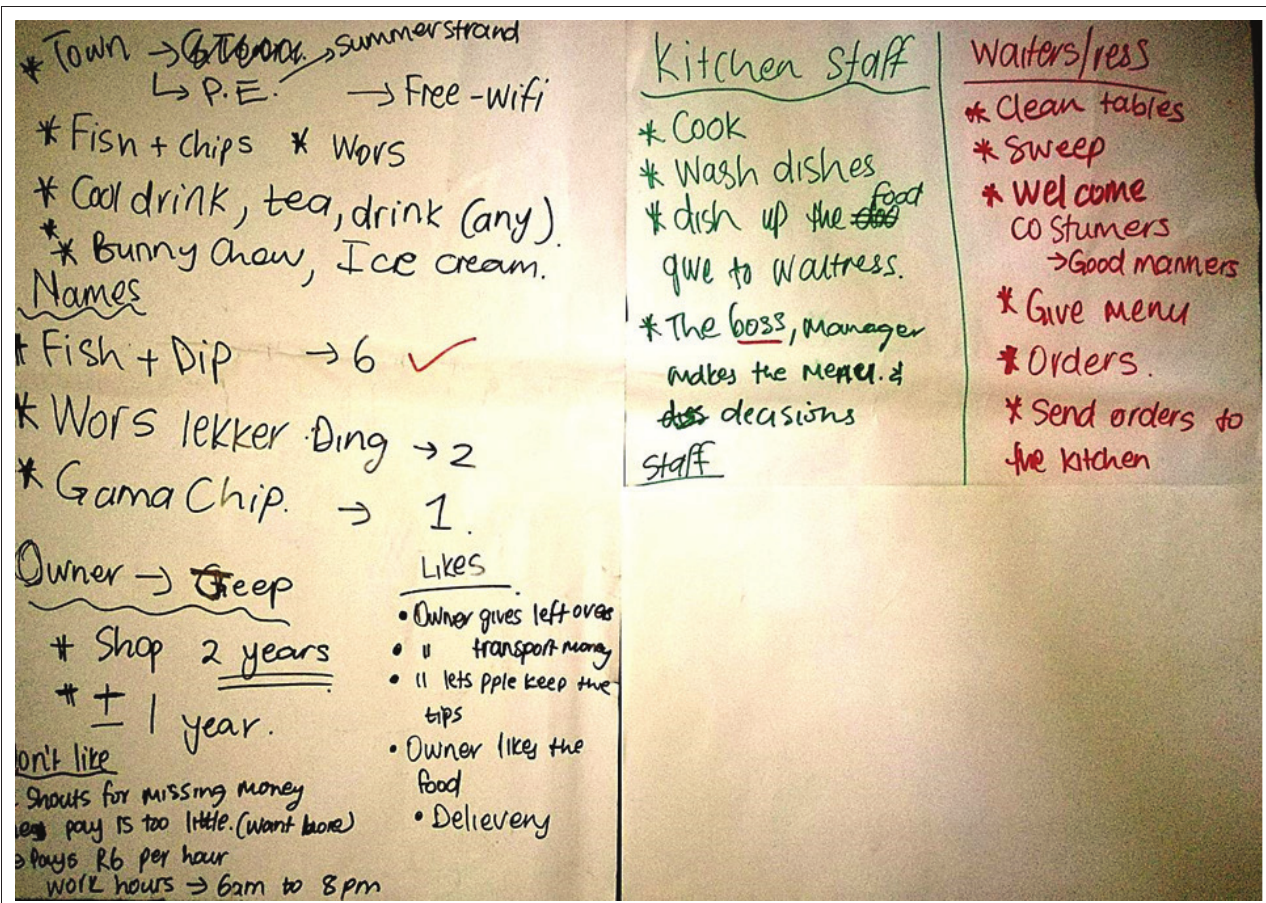
FIGURE 1: The brainstorming notes gathered from the building belief stage working out of